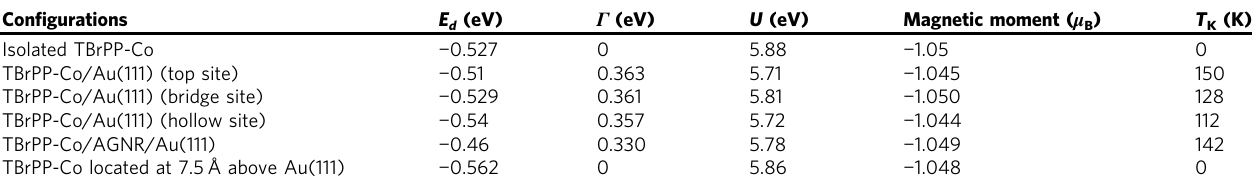
Table 1 Structure